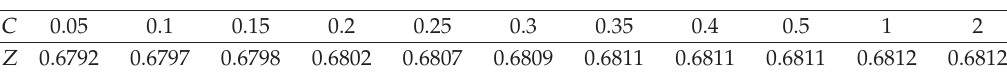
Table 6: The e ff ect of C on Z